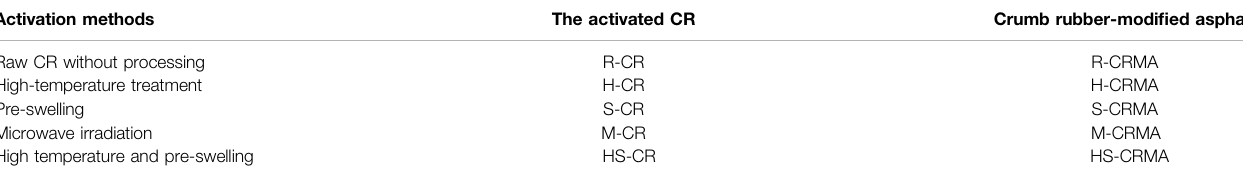
TABLE 2 | The abbreviations of various activation methods of crumb